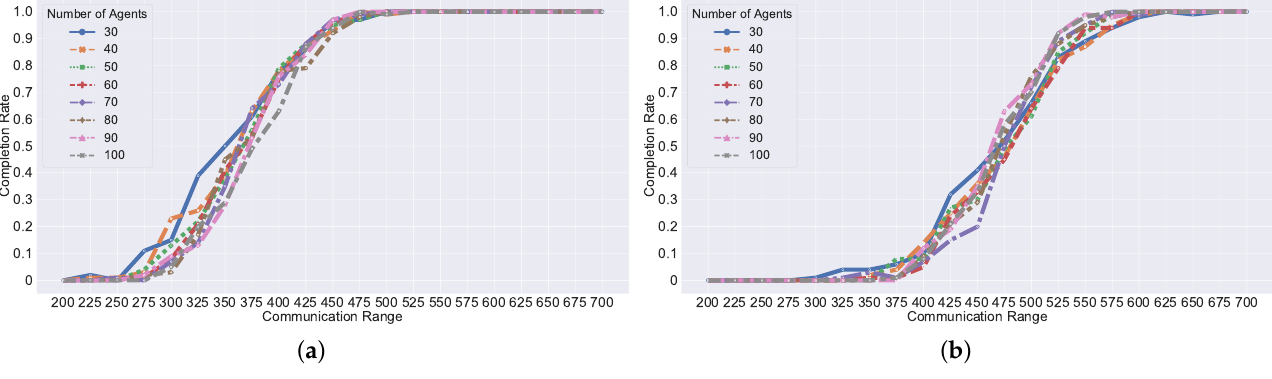
Figure 9. Compeletion rate comparison of two methods with election threshold of half of swarm. ( a ) Our proposed method with respect to different swarm size. ( b ) The Raft-based method with respect to different swarm